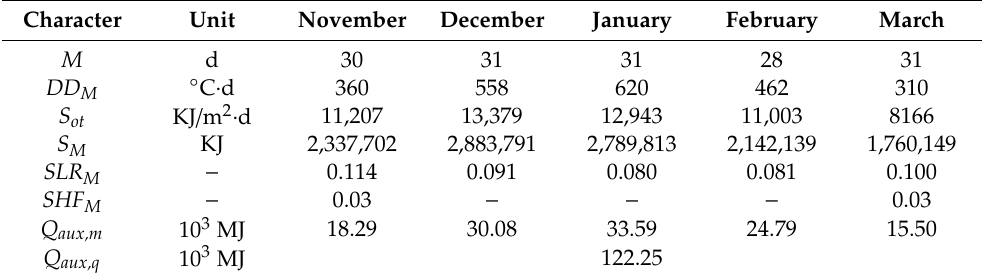
Table 18. Calculation for the yearly auxiliary energy demand in two-story brick-concrete